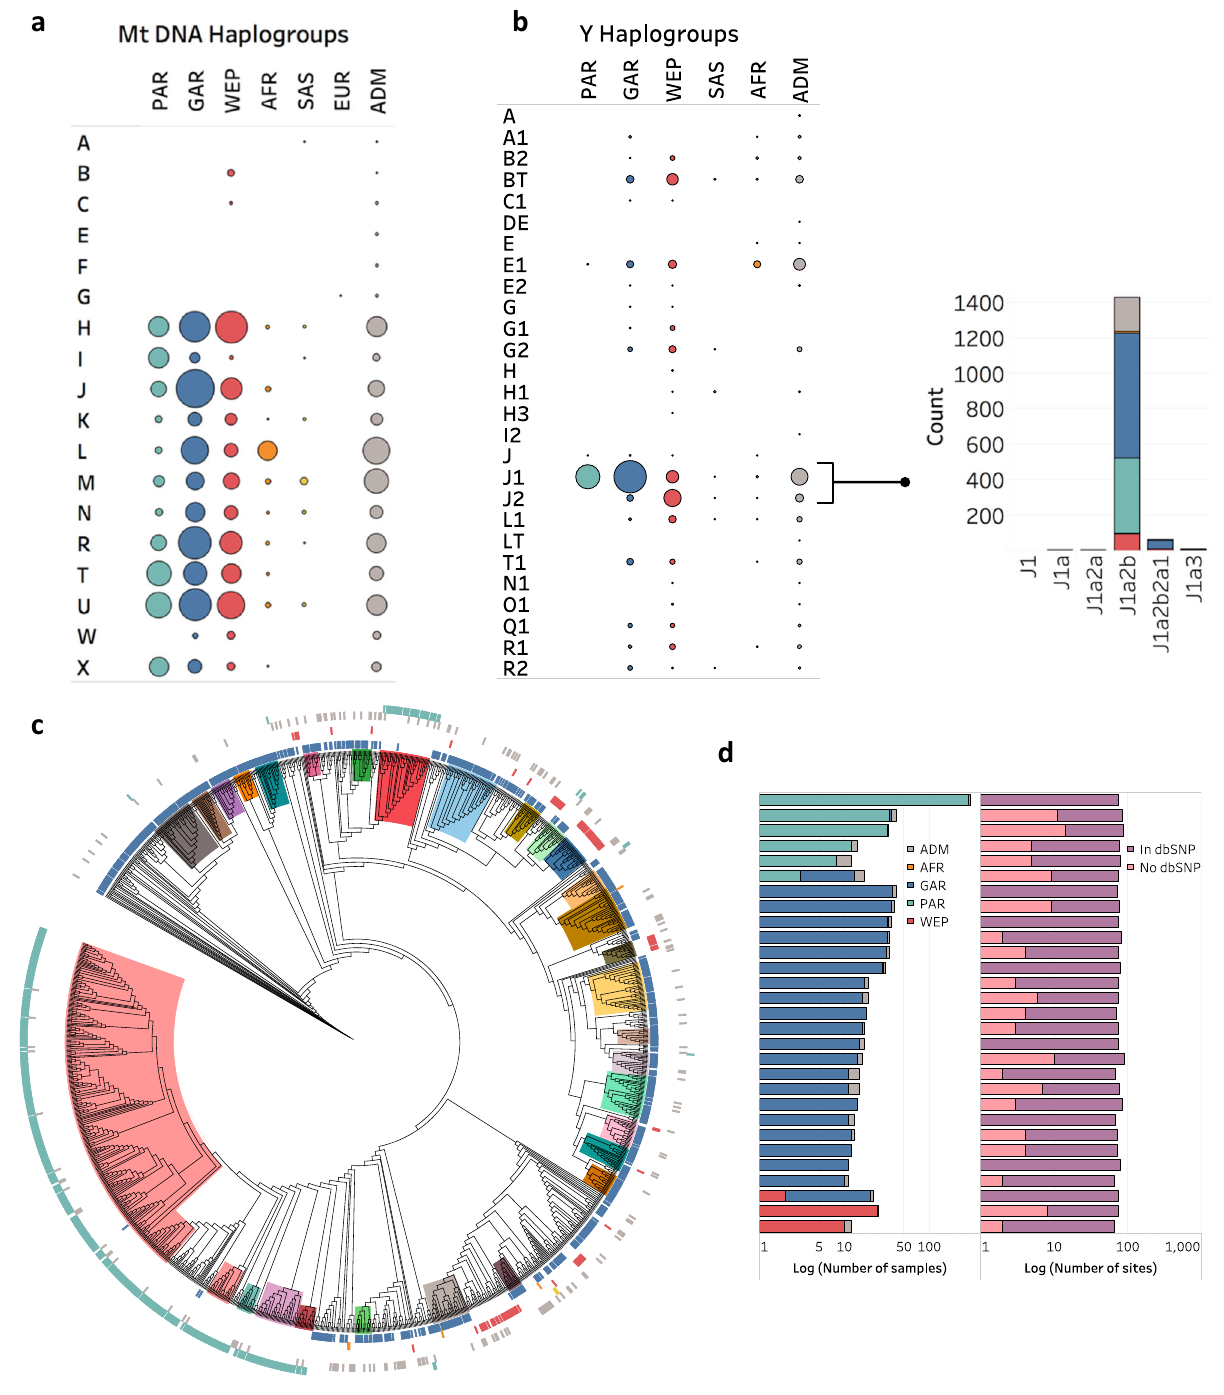
Fig. 6 Chr Y and mtDNA haplogroups of QGP samples. a mtDNA haplogroup and b Chr Y assignments in the various QGP subpopulations. Number of samples is indicated by circle size. Inset shows breakdown for J1 clade. c Maximum likelihood tree for samples assign ed to J1a2b Y haplogroup (bootstrap > 90%). Clusters are de fi ned at genetic distance cutoff 5 × 10 − 4 . Outer circles indicate autosomal ancestries (QGP subpopulations) and are colored accordingly. Clusters inside the tree are colored independently based on the identi fi ed 29 unique sub-haplogroups. d Partitioning of the 29 sub- haplogroups amongst autosomal ancestries and numbers of underlying SNVs indicating presence in dbSNP build 151. Source data are provided as a Source Data fi